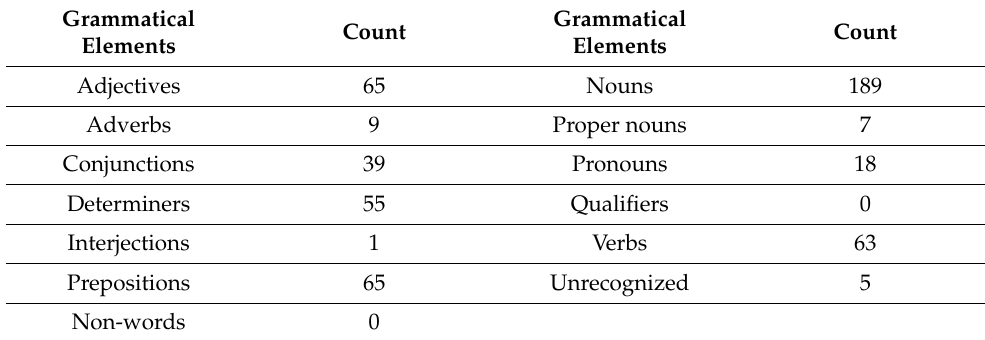
Table 12. Text Composition for Online Exercise Content (Source: Lumos Text Complexity